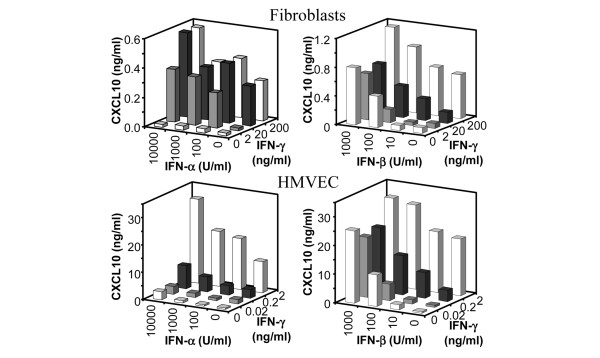
CXCL10 induction by combinations of interferons in fibroblasts and human microvascular endothelial cells. Monolayers of fibroblasts or human microvascular endothelial cells (HMVEC) were incubated with combinations of IFN-α or IFN-β and IFN-γ. Results represent the mean CXCL10 concentration (ng/ml) measured in the culture supernatant (three or more independent experiments).